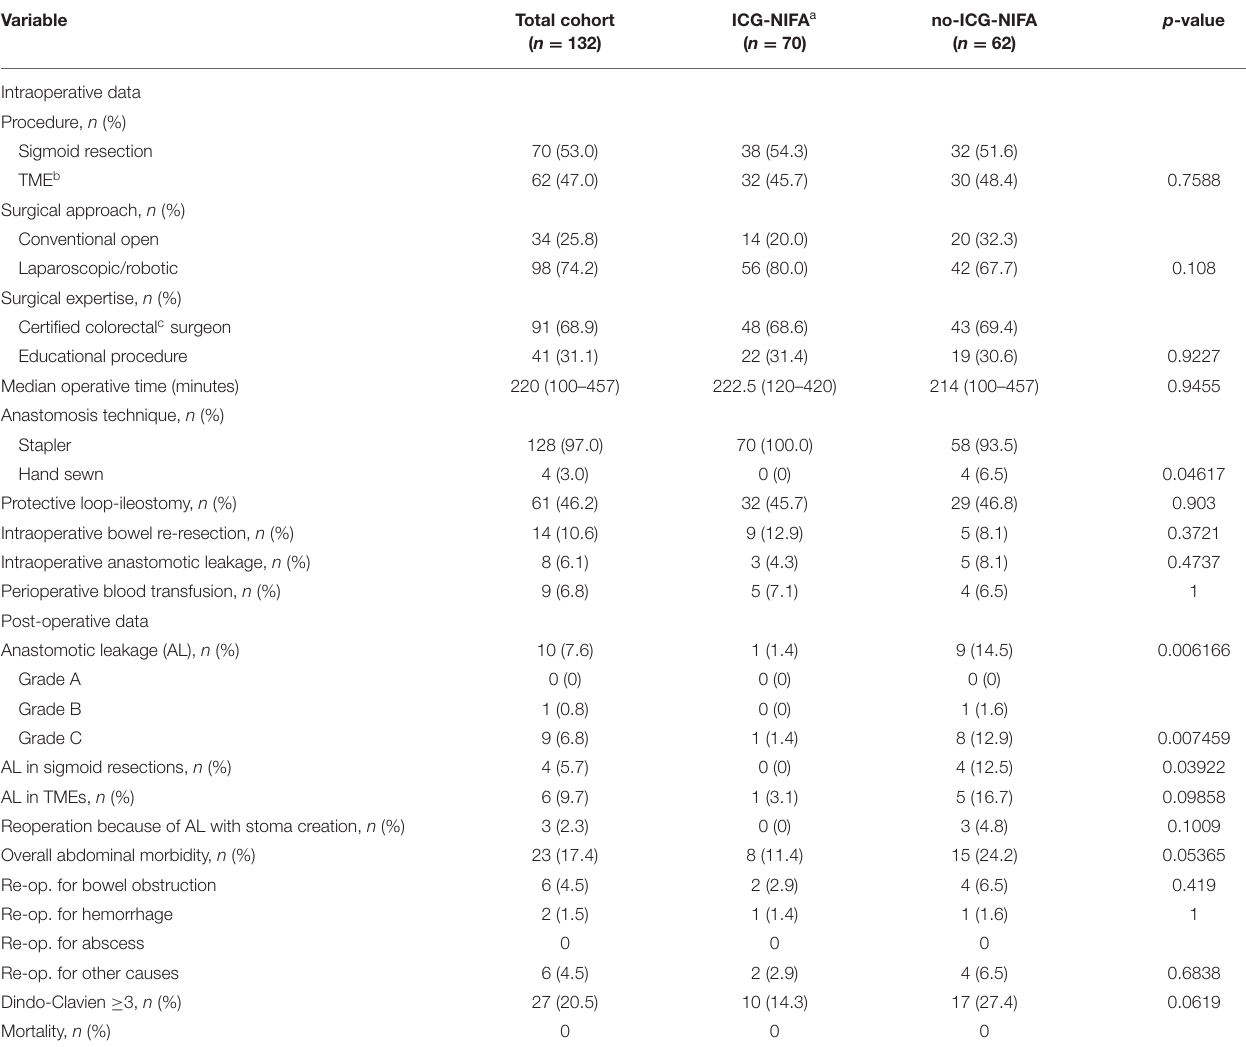
TABLE 2 | Intra- and post-operative data in the ICG-NIFA and no-ICG-NIFA groups.